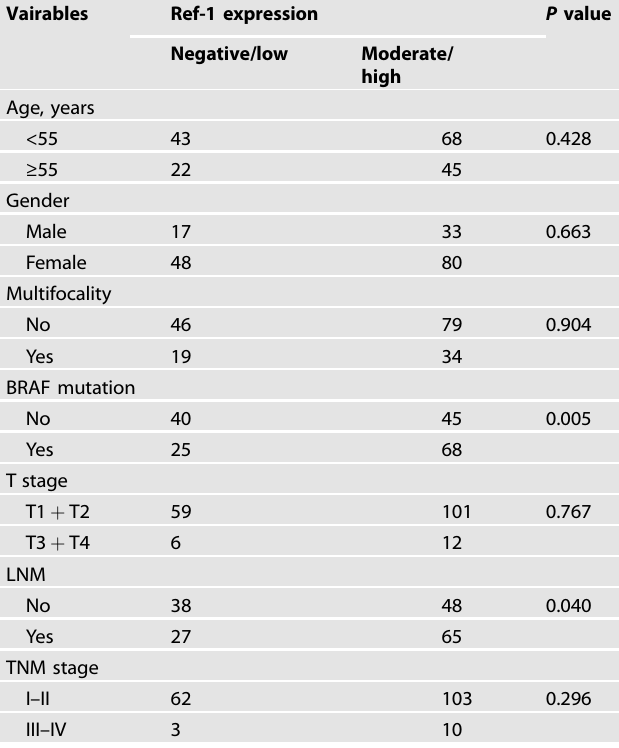
Table 1. Analysis of Ref-1 expression and clinicopathological features in